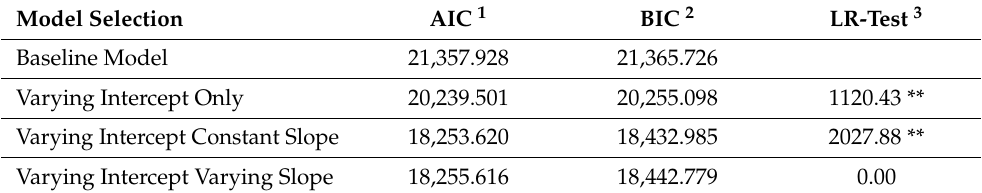
Table 1. Model Fit